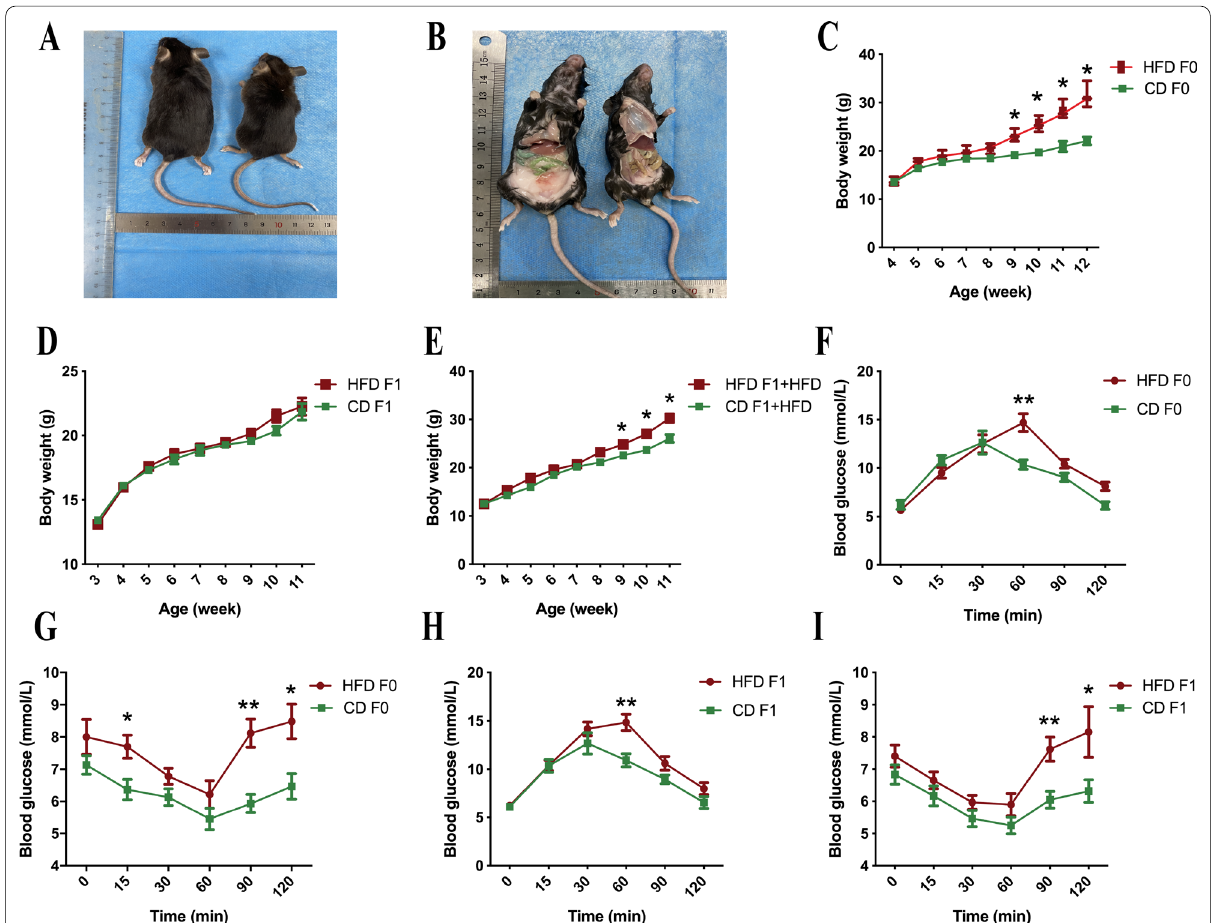
Fig. 1 Effects of HFD on the metabolic phenotypes in F0 and F1 mice. A , B Anatomic features of the HFD and CD mice. C Weekly body weights of F0 mice between the HFD and CD groups (n 6 for each group). D Weekly body weights of F1 mice fed the CD (n 6 for each group). E Weekly = = body weights of F1 mice fed the HFD (n 6 for each group). F Blood glucose levels of F0 mice between the HFD and CD groups when GTTs are = applied (n 5 for each group). G Blood glucose levels of F0 mice between the HFD and CD groups when ITTs are applied (n 5 for each group). H = = Blood glucose levels of F1 mice between the HFD and CD groups when GTTs are applied (n 5 for each group). I Blood glucose levels of F1 mice = between the HFD and CD groups when ITTs are applied (n 5 for each group). * p < 0.05, ** p < 0.01. HFD high-fat diet, CD control =